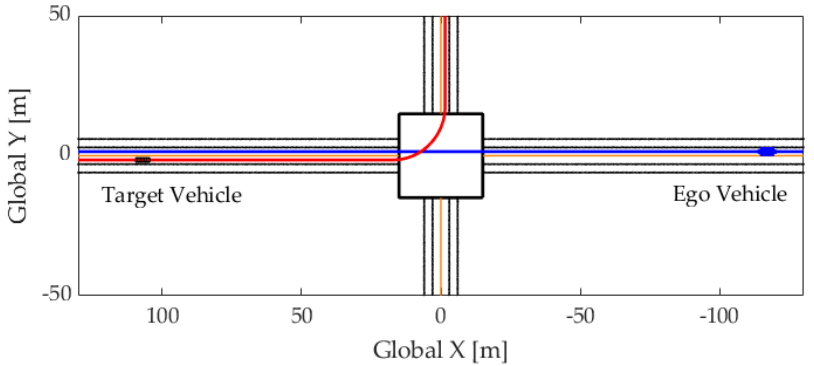
Figure 11. LTAP-OD scenario for case study.